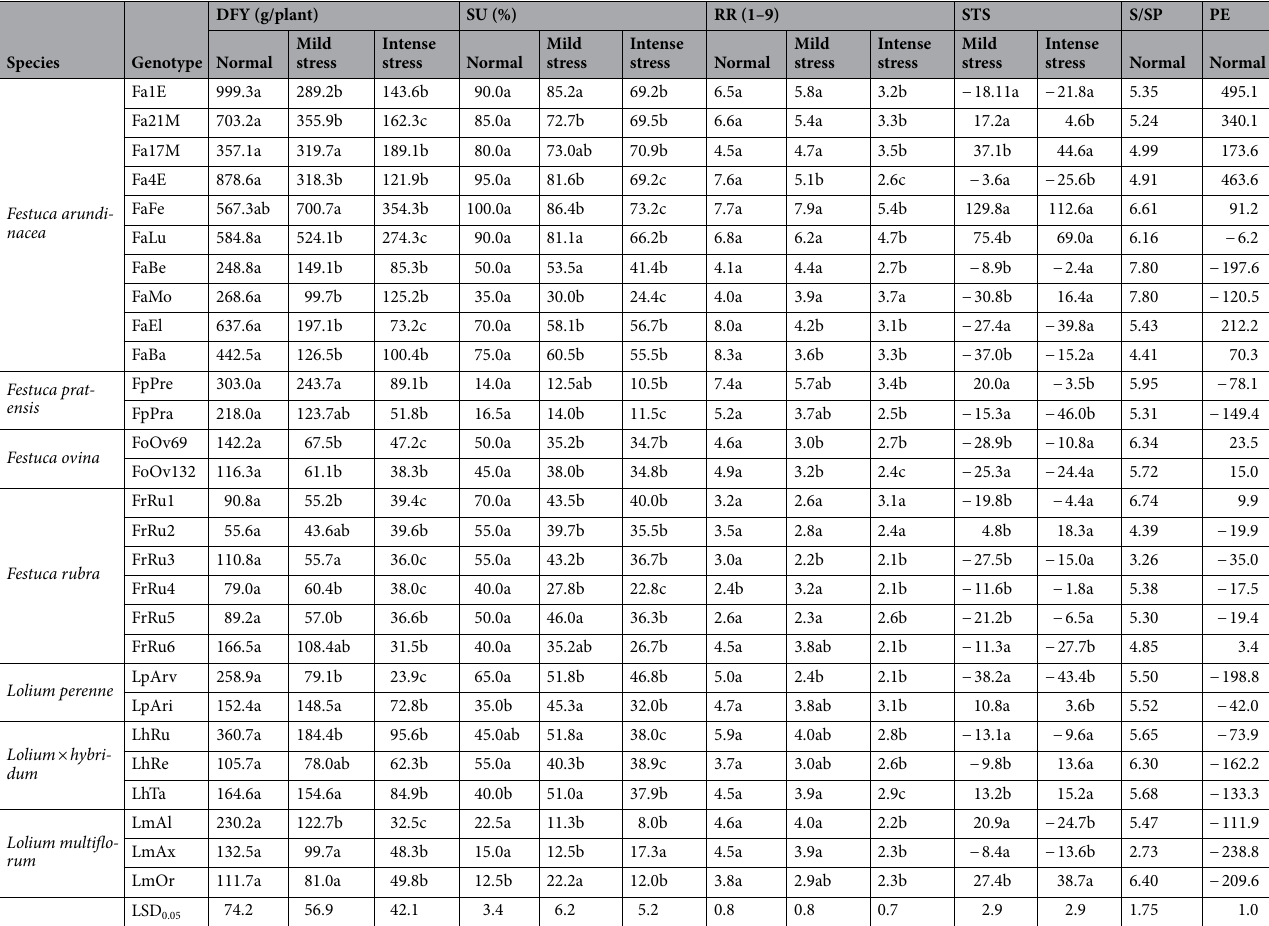
Table 2. Means of measured traits in 28 genotypes of various grass species under normal, mild and intense drought stress. DFY dry forage yield, SU survival, RR recovery rate, STS stress tolerance score, S/SP summer dormancy, PE persistence. In each row, (among three irrigation environments) means followed by a common letter are not significantly different according to the LSD test at an alpha level of 0.05. In each column, If the difference between the means is greater than the LSD 0.05 , then the means (among genotypes) are significantly different. For information about plant materials and their origins see Table